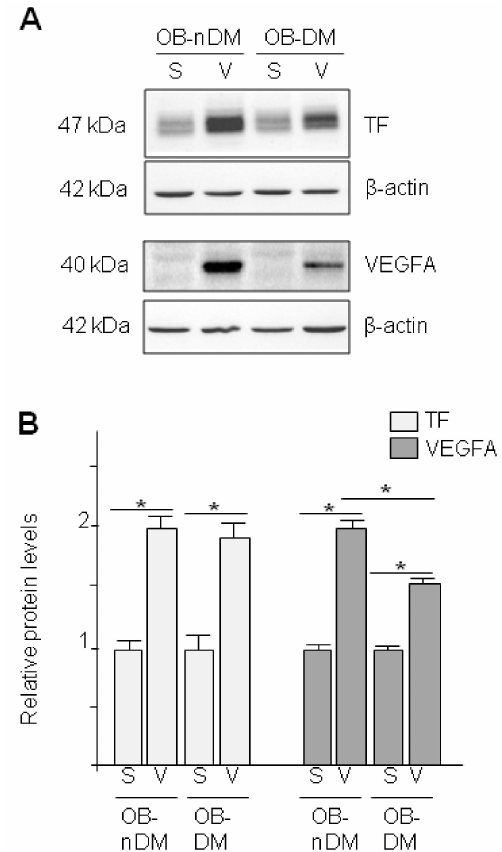
Figure 5. TF and VEGF expression in in Subcutaneous or Visceral Derived ASCs from Diabetic / No Diabetic Patients with Obesity. ( A ) TF and VEGFA expression in ASCs obtained from SAT (S) or VAT (V) in obese patients (OB) in presence (DM) or absence (nDM) of diabetes. Western blot analysis of TF and VEGFA proteins in ASCs. To test for equal loading Western blots were reproved by β -actin; ( B ) Quantitative analysis of TF and VEGFA to β -actin relative